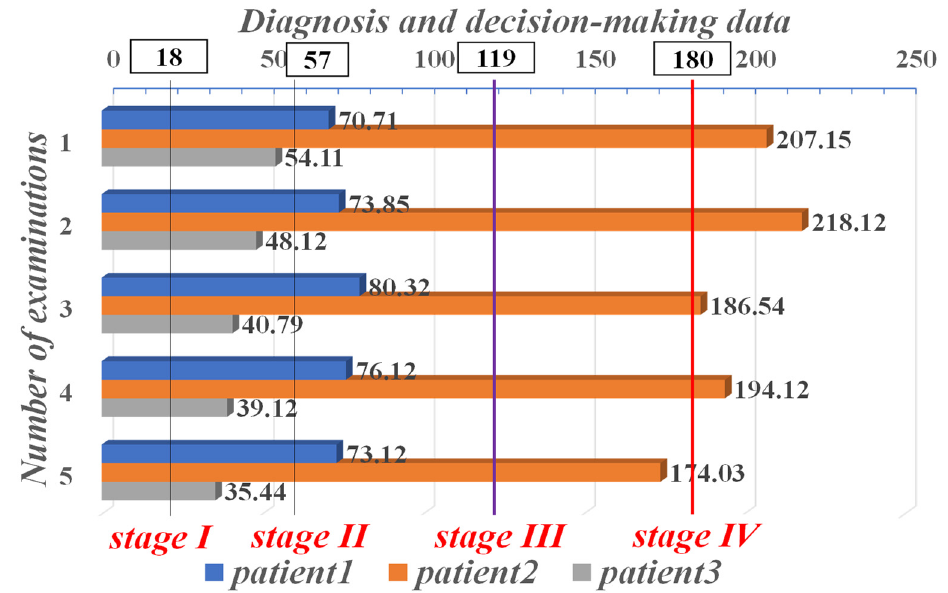
Figure 9. Auxiliary system staging diagnostic results for three representative patients in three groups with five examination data. Table 6. The data of various diagnostic and decision parameters during the treatment of a typical NSCLC